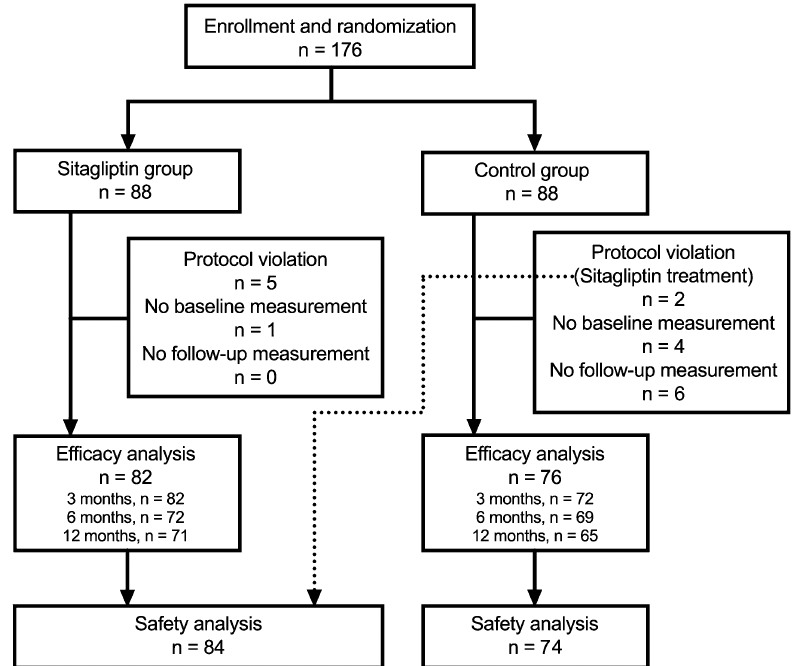
Figure 1. Flowchart of subject enrollment. A total of 176 patients were enrolled and randomly allocated into sitagliptin and control groups. Of the 176 participants, 18 were excluded from the efficacy analysis because of protocol violation, no baseline measurements, and no follow-up measurements. Two of the seven patients with protocol violation were treated with sitagliptin, despite being assigned to control group. These two patients who were treated with sitagliptin despite being assigned to control group were included in the safety analysis within sitagliptin group. The number of participants who completed blood tests of each follow-up visit is provided at the blocks of efficacy